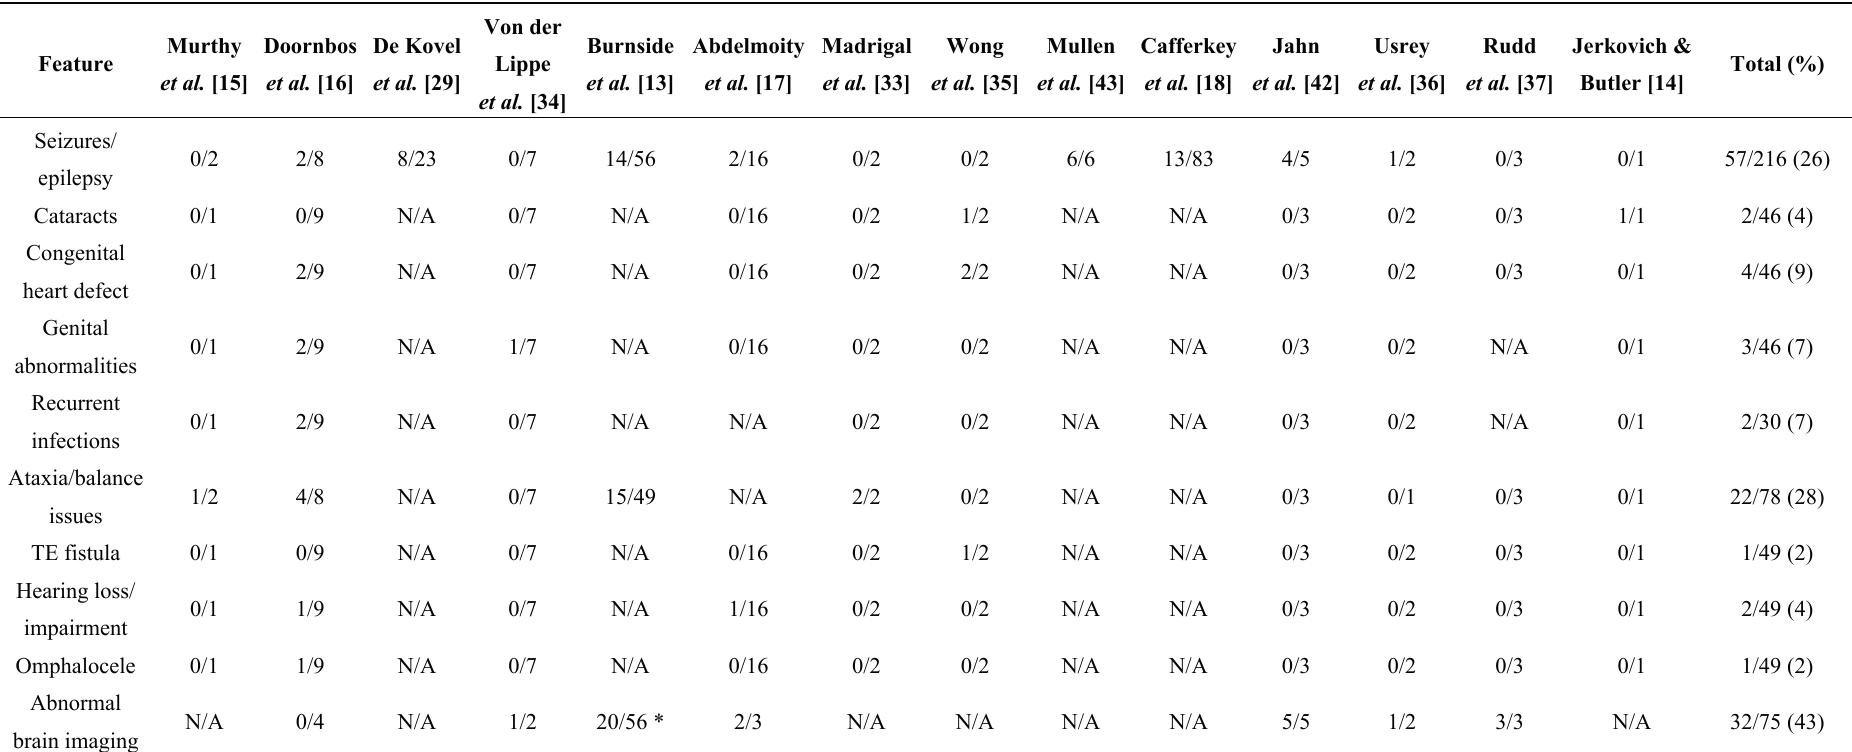
Table 5. Literature Review of Other Related Medical Concerns for Individuals with Chromosome 15q11.2 BP1–BP2 Microdeletion Syndrome.